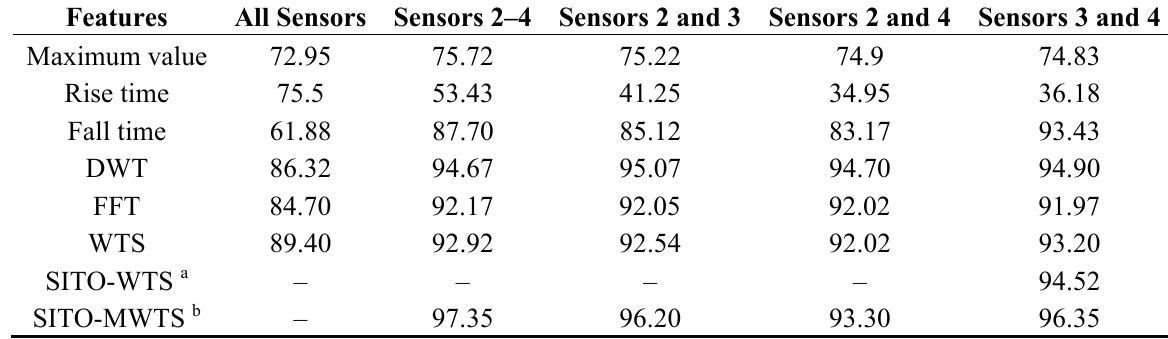
Table 13. Classification rates (CR, %) of different features in